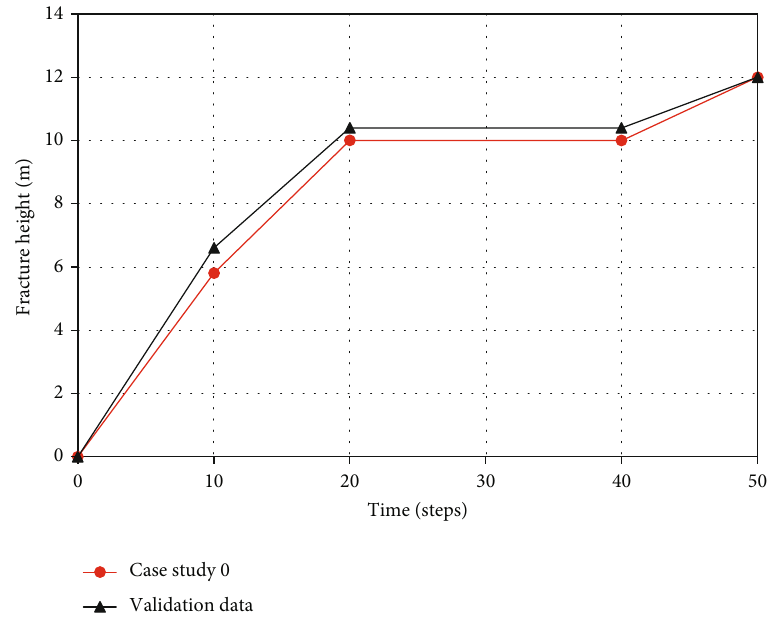
Figure 10: Comparison of fracture height between case 0 and validation data.